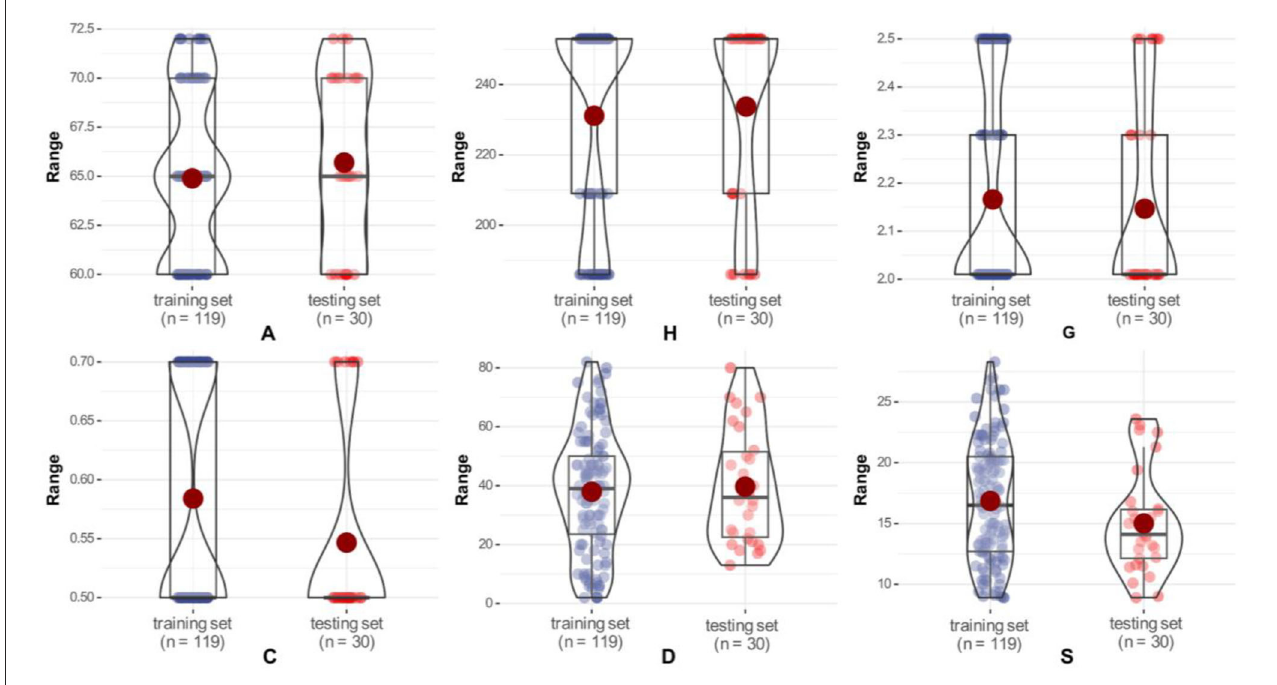
FIGURE4 Data distribution of the training set and testing set for the model.